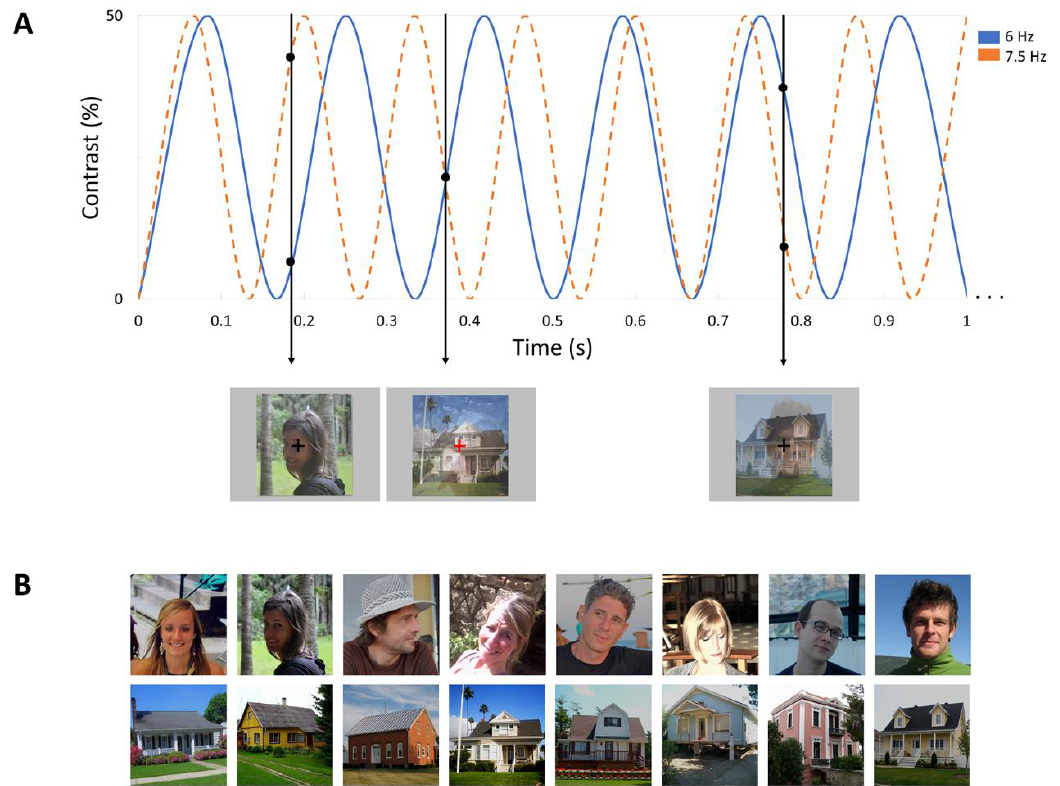
Figure 1. Experimental design. ( A ) Illustration of a stimulation sequence, with houses presented at 6 Hz and faces presented at 7.5 Hz. The presentation rates (6 and 7.5 Hz) were counterbalanced across the two stimulus types. In total, four sequences of 60 s were administered. Contrast of all images was modulated from 0 to 50%. The first black arrow indicates what was presented at 0.18 s: the second face was presented at around 40% contrast at this timepoint, whereas the second house was presented at around 10% contrast. ( B ) Examples of selected faces and houses.